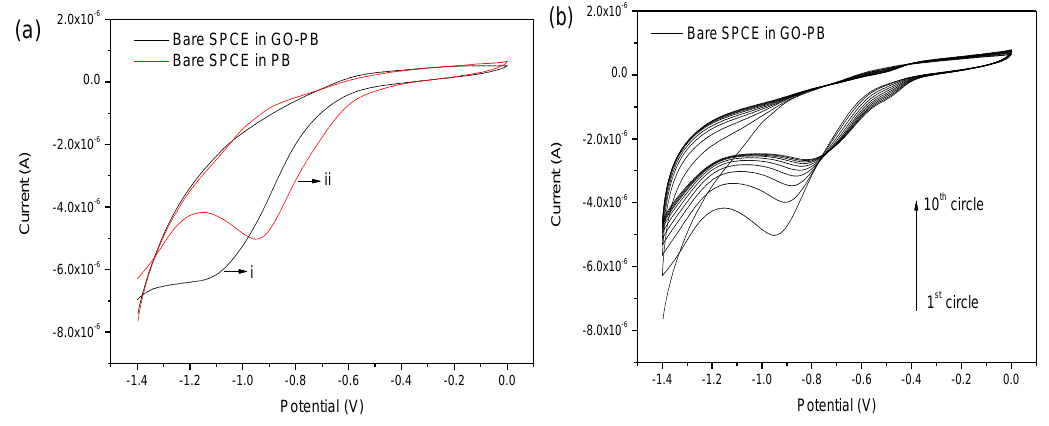
Figure 2. ( a ) CVs of bare SPCE in phosphate buffer (i) and phosphate buffer containing GO (ii) for the first circle; ( b ) CVs of bare SPCE in phosphate buffer containing GO (10